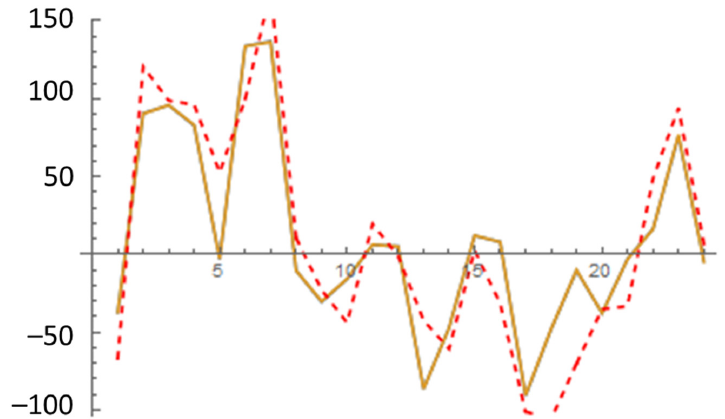
Figure 6. Correlation of CNN predictions of the market sentiment from the unexpected monthly cost-of-trading (TC, brown, solid) with predictions of the unexpected order volume (OV, red, dash). ρ ε ,TC ≈ ρ ε ,OV ≈ 0.913. For comparability, the scale of market sentiment was increased by 100. The Equation (9) can be recast in the (dynamic) version of [20] liquidity measure.